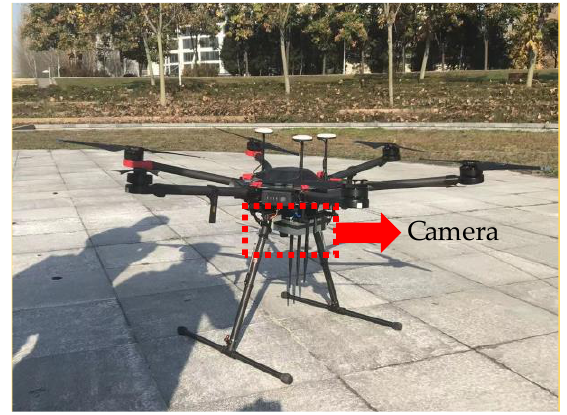
Figure 9. Homemade UAV platform based on DJI M600 and 1080P camera.